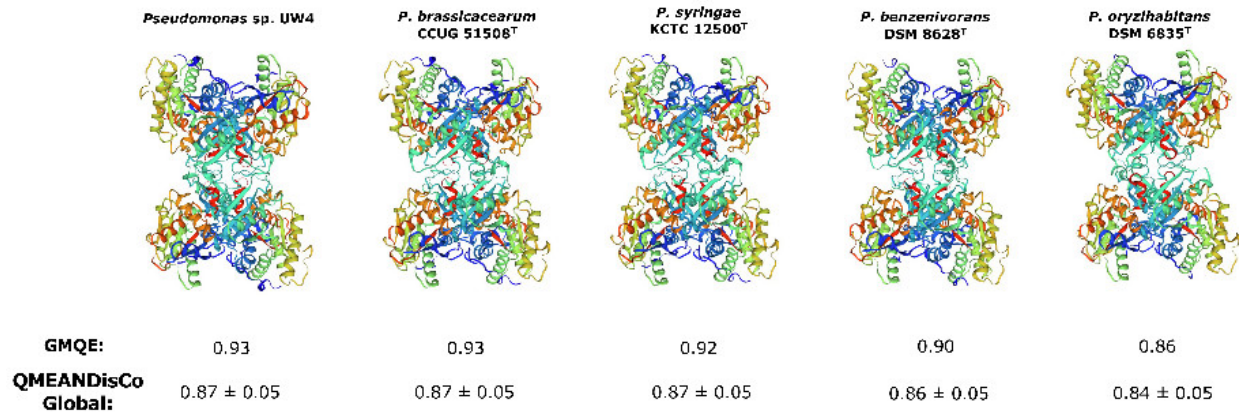
Figure 3. Models of the different ACC deaminase enzymes from selected Pseudomonas . The models were created in Swiss-Model [73] using the crystal structure of ACC deaminase from Burkholderia (formerly Pseudomonas ) sp. ACP as template (SMTL ID: 1tzm.1) [74]. GMQE—Global Model Quality Estimate; QMEANDisCo is a composite score for single model quality estimation.